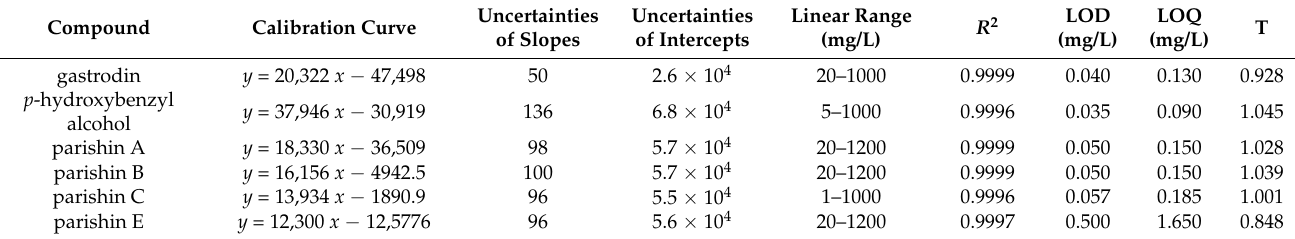
Figure 3. Typical HPLC chromatogram of blank solvent (50% MeOH), GR decoction piece (No. S2), GR standard decoction (No. Y2), commercially available GR formula granule, and mixed standard solution. Table 1. In this experiment, the standard curve, limit of detection (LOD, S/N = 3), and limit of quantitative (LOQ, S/N = 10) of six index components of GR were determined by HPLC. All calibration points were repeated three times.